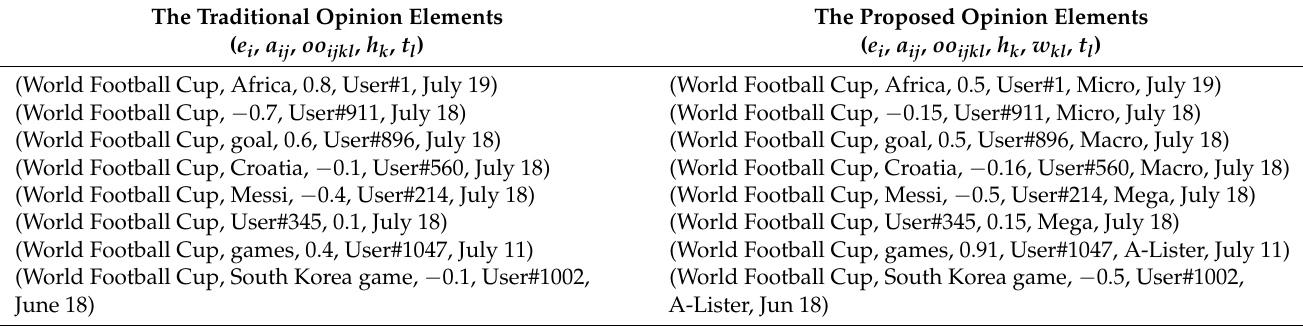
Table 7. Opinions representation between the classic elements and the new proposed